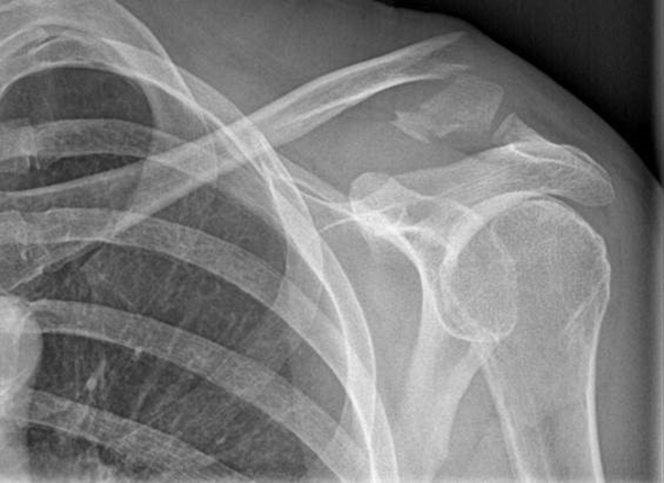
Radiograph of patient with Neer type 2 fracture.